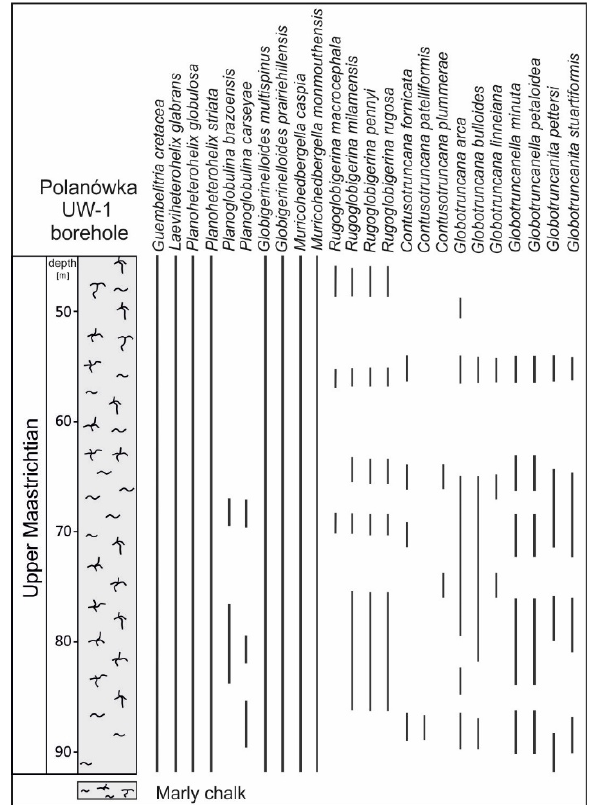
Figure 2. Stratigraphic distribution of planktonic foraminifera in the Polanówka UW-1 borehole section.